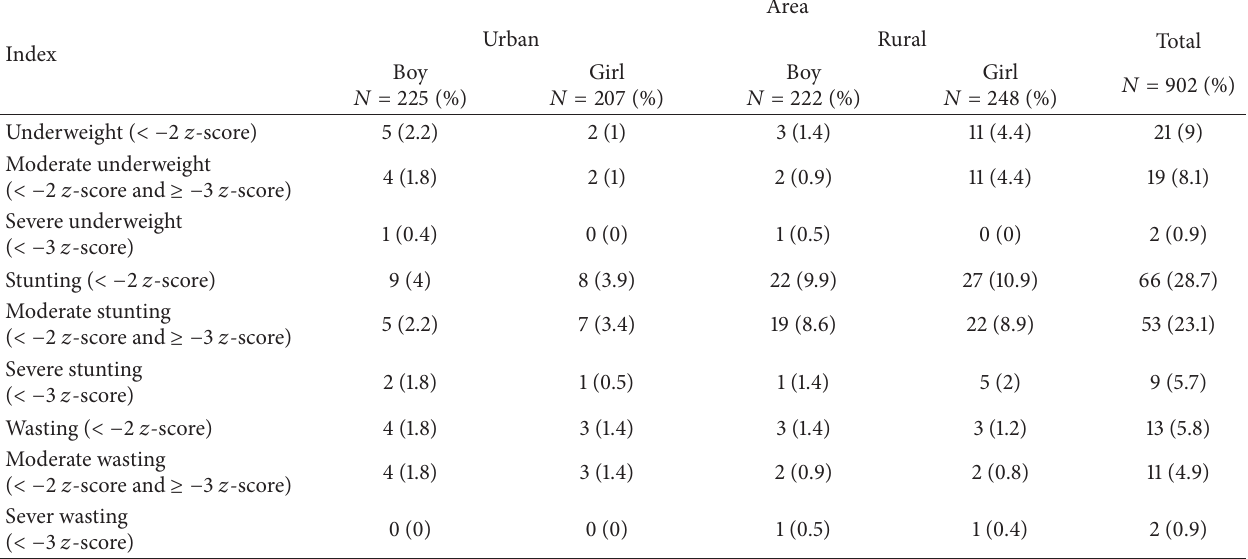
Table 2: The distribution of nutritional status (underweight, stunting, and wasting) in children in Salmas.